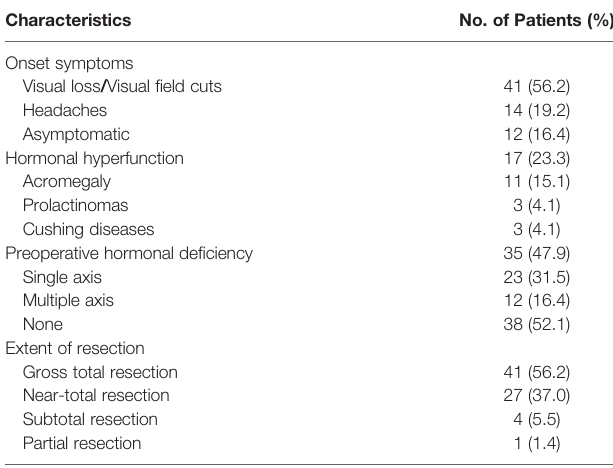
TABLE 1 | Clinical characteristics of